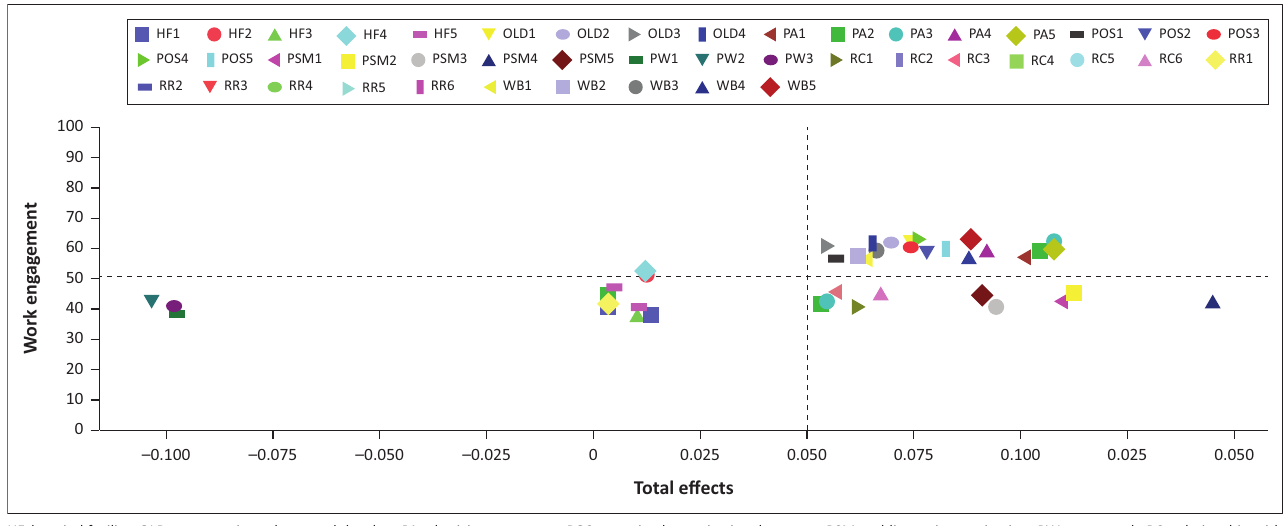
FIGURE 2: Importance–performance map of